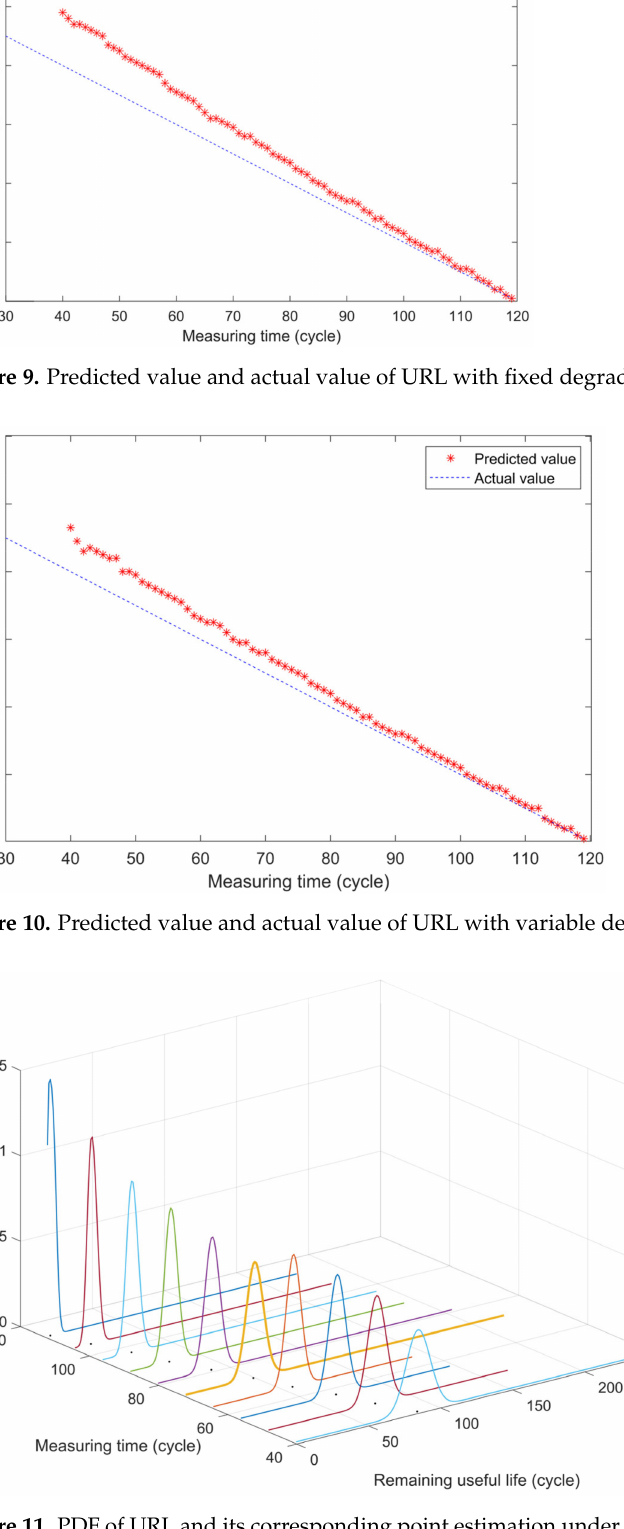
Figure 11. PDF of URL and its corresponding point estimation under variable degradation